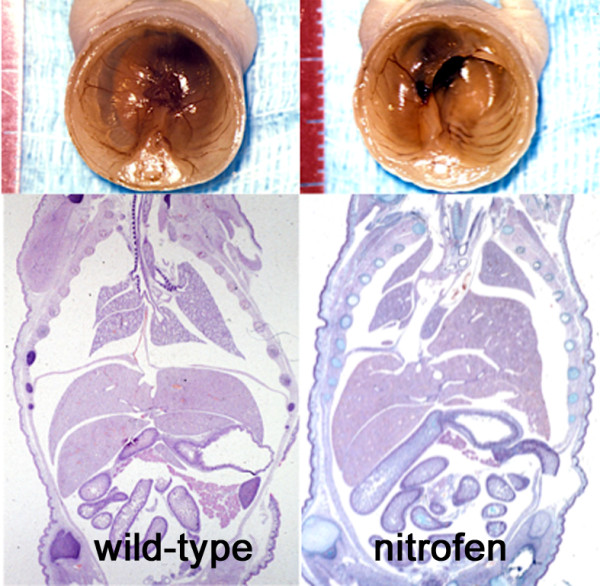
Experimental CDH in rats. Administration of 100 mg of the herbicide nitrofen on gestational day 9.5 to pregnant rats induced the malformation in 40 to 80% of the offspring. On the left, neonatal autopsy of an untreated, wild-type rat shows an intact diaphragm (above) that can also be seen in the frontal section of the trunk (below). On the right, similar preparations of a rat with nitrofen-induced CDH show a large postero-lateral diaphragmatic orifice, herniation of the liver into the thorax, displacement of the mediastinum to the contralateral side and lung hypoplasia.